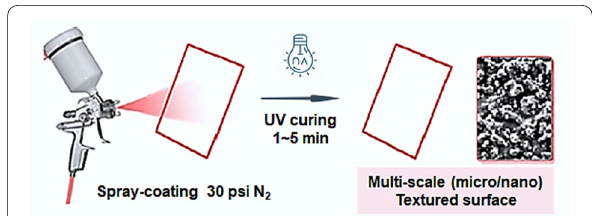
Fig. 5 Schematics depicting spray-coating technique [66] Copyright 2018 Industrial and Engineering Chemistry Research